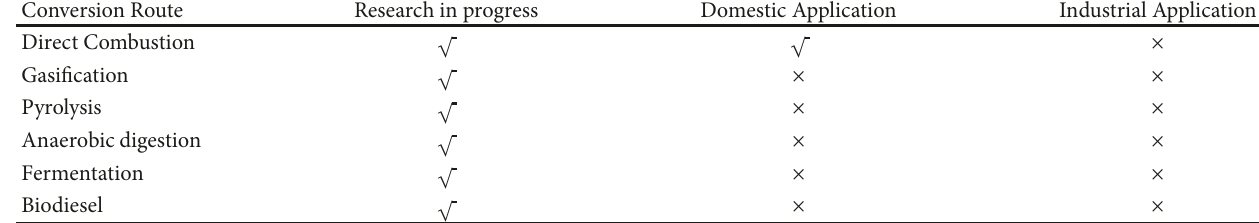
Table 9: Progress of research and application of bioenergy as fuel in Nigeria.